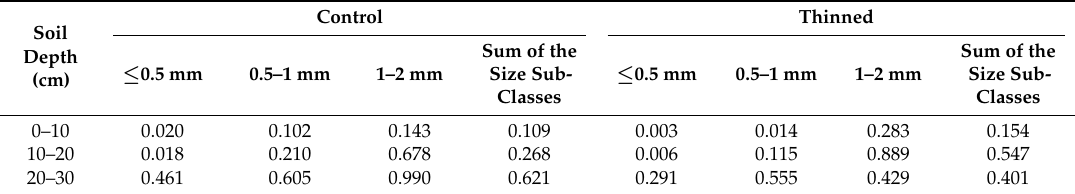
Table 1. p values for one-way ANOVA of the seasonal dynamics of P. massoniana fine root biomass at depth intervals of 0–10, 10–20, and 20–30 cm.